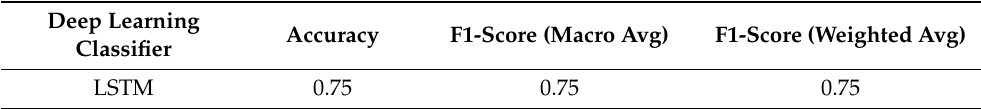
Table 8. Symptom Classification Results.